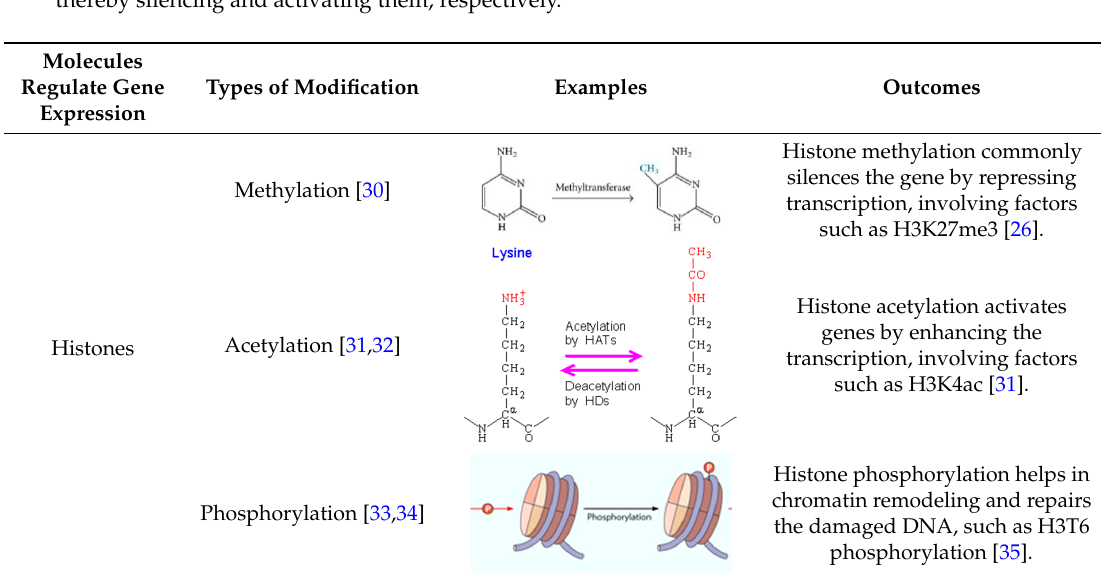
Table 1. Epigenetic regulations of gene expression by histones. Summary of the type of modifications that histones undergo to regulate gene expression by repressing or enhancing gene transcription, thereby silencing and activating them,